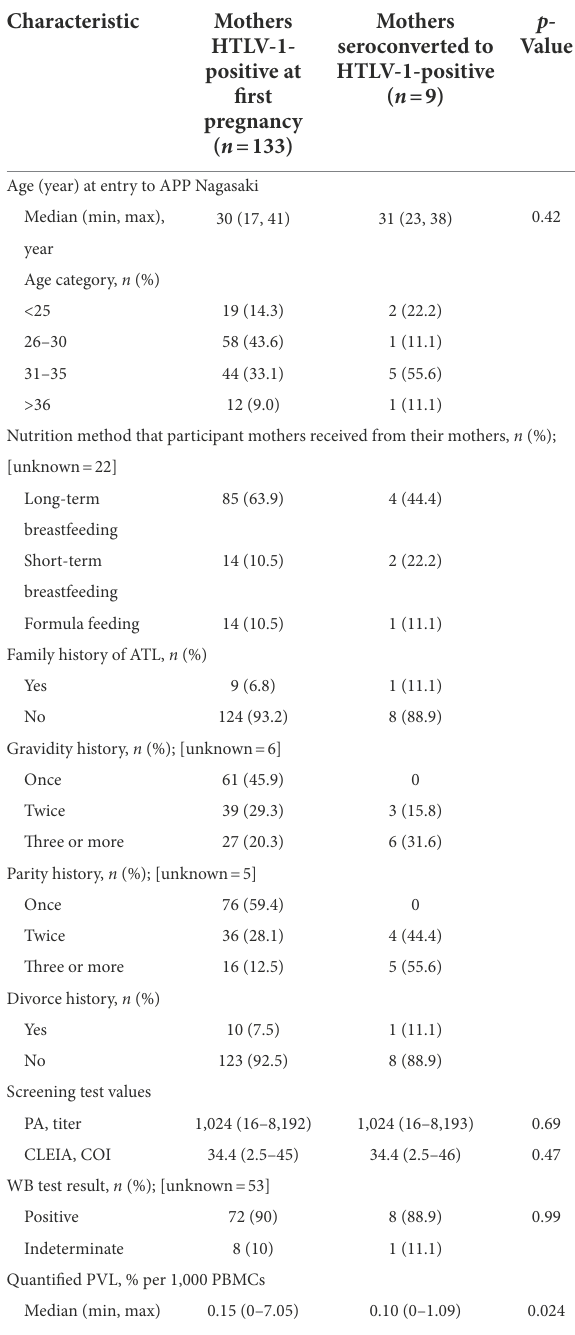
TABLE 1 The characteristics of HTLV-1-positive or HTLV-1- seroconverted pregnant women.